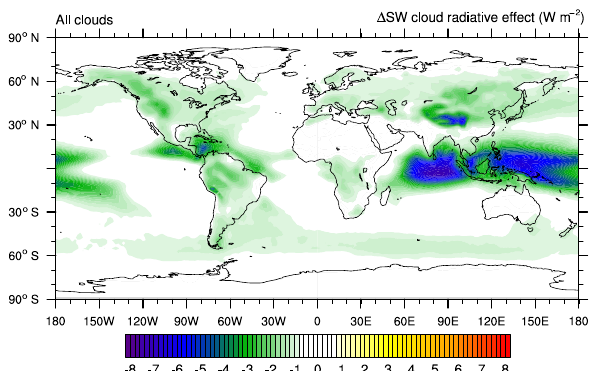
Figure 8. The global change in the SW cloud radiative effect pre- dicted by the ECHAM-HAM model when the standard parameteri- zation of the SW asymmetry factor is substituted by the parameteri- zation using severely roughened ice particles. In this simulation the new SW asymmetry factors were applied to all ice particles both in cirrus and in mixed-phase